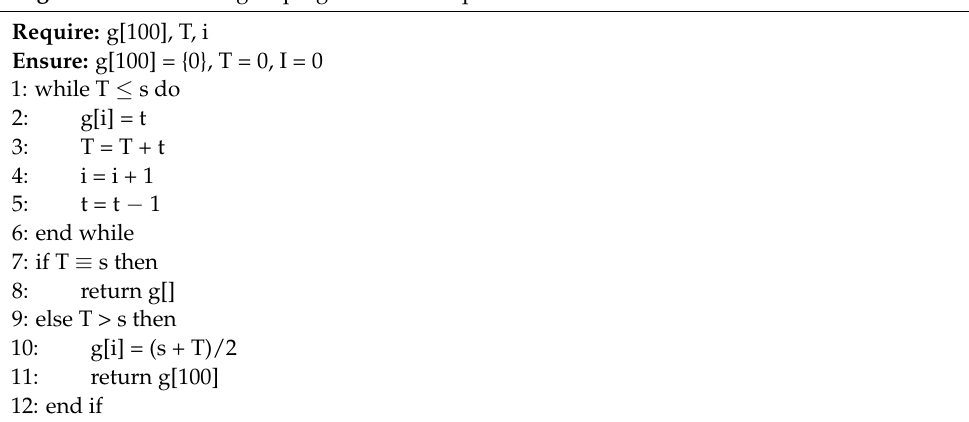
Algorithm 1. Find the grouping of Boolean